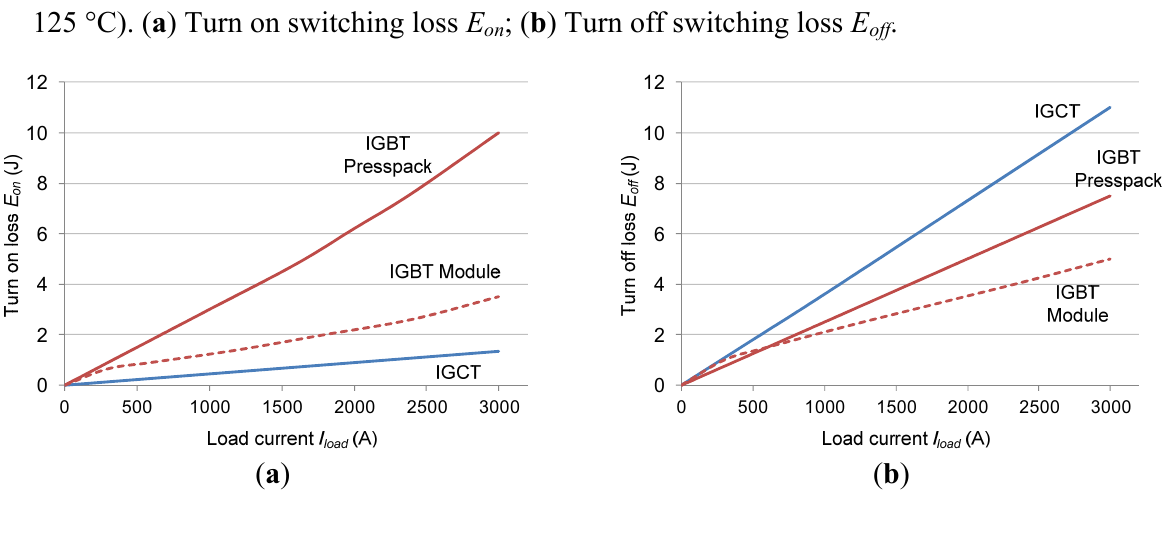
+E ; ( b ) Switching loss on on off